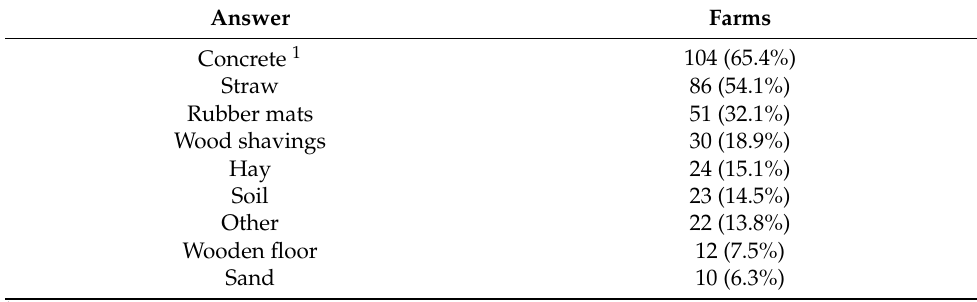
Table 4. Floor and bedding in the stables (multiple choice; n =